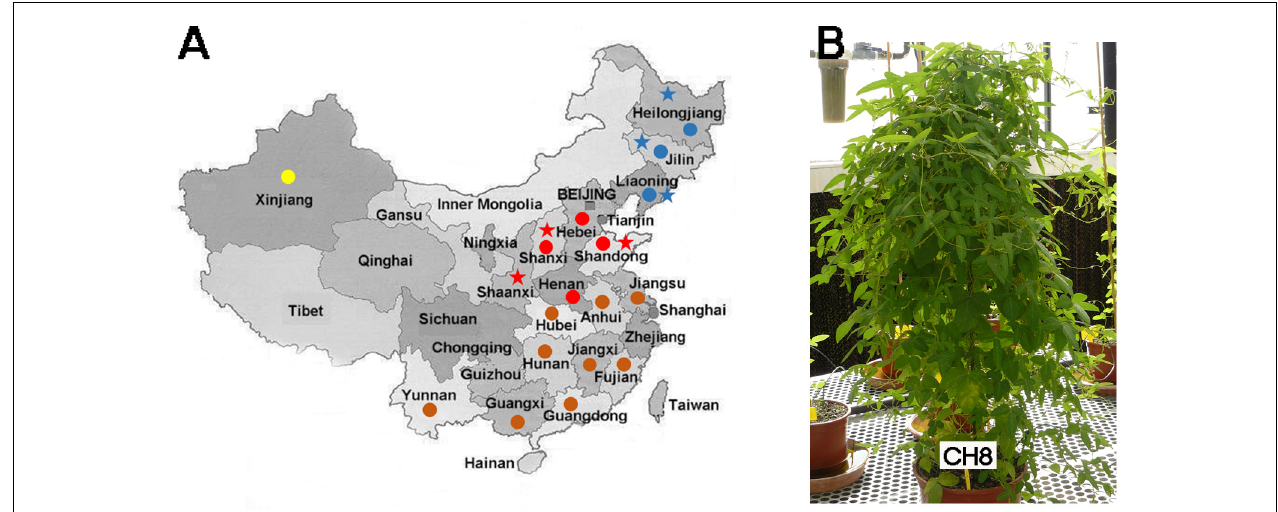
FIGURE 1 | (A) Biogeography of Glycine soja cultivars analyzed in this work (stars) and soybean-nodulating rhizobia (circles) studied by Tian et al. (2012). Blue and red stars indicate Northern and Central Chinese provinces, respectively. Blue, red, brown, and yellow circles indicate Northern, Central, Southern, and Western Chinese provinces respectively. According to Tian et al. (2012), Sinorhizobium species are predominant in Central China whereas Bradyrhizobium species predominate in Northern and Southern China. In Xinjiang (Western China), the proportions of Sinorhizobium and Bradyrhizobium species are similar. (B) A wild G. soja cultivar (CH8, from Heilongjiang, Northern China) grown in greenhouse conditions in Seville,